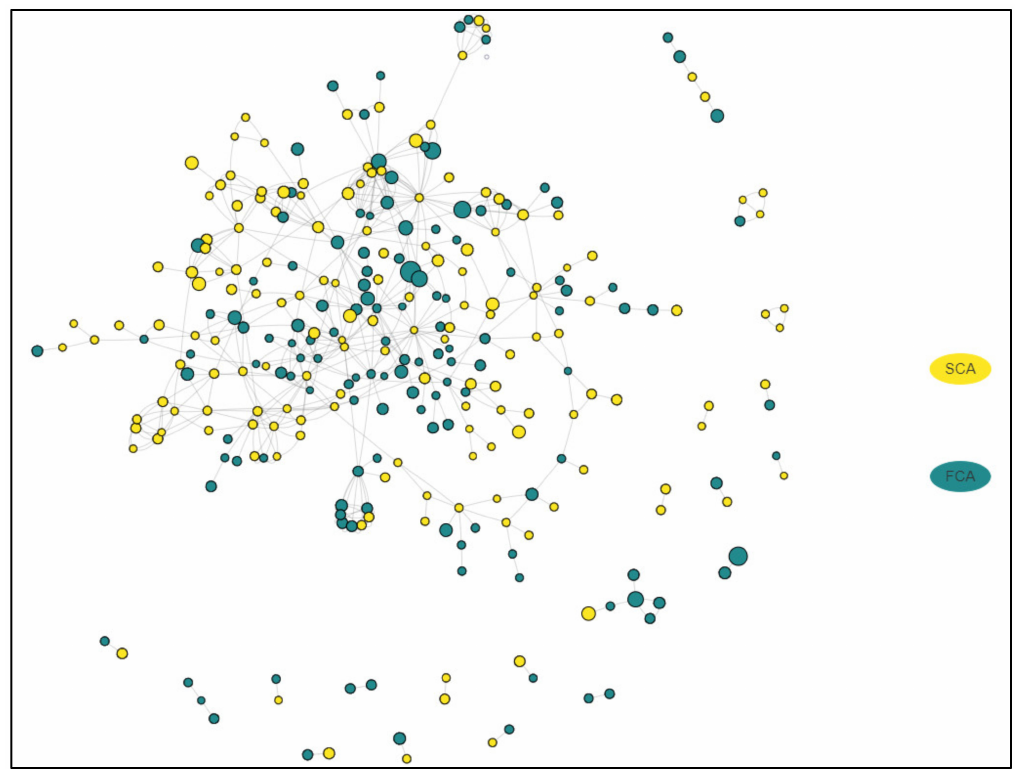
Figure 3. Interactive network representing the relations between all DEGs in functioning (FCA) and silent (SCA) corticotroph adenomas. The figure shows a representation of the complexity of the results and the interactions that are present. An interactive version of this figure is presented at https: // alexeie.github.io / corticotroph-adenomas / . Detailed information on all the key interactions in the dataset, including the involved genes and the known relationships between them, can be accessed via the link. Genes higher expressed in FCA group are green; genes higher expressed in SCA are yellow. The size of the round circles is proportional to the log2 fold